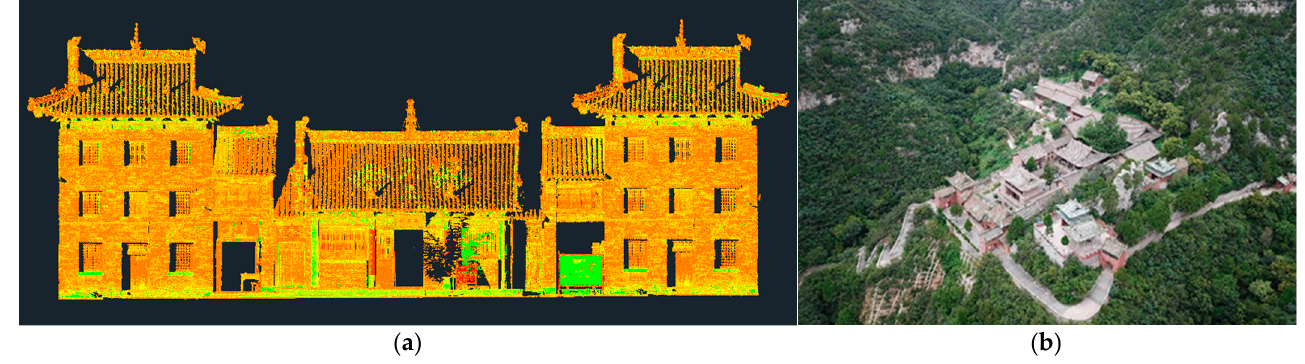
Figure 9. Preprocessed data: ( a ) point cloud and ( b ) UAV image.